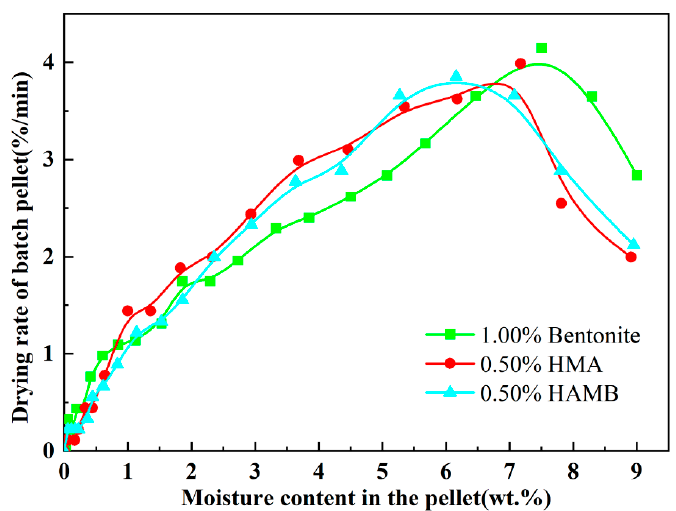
Figure 4. Drying characteristic curve of green pellets with different binders under same drying con- ditions.